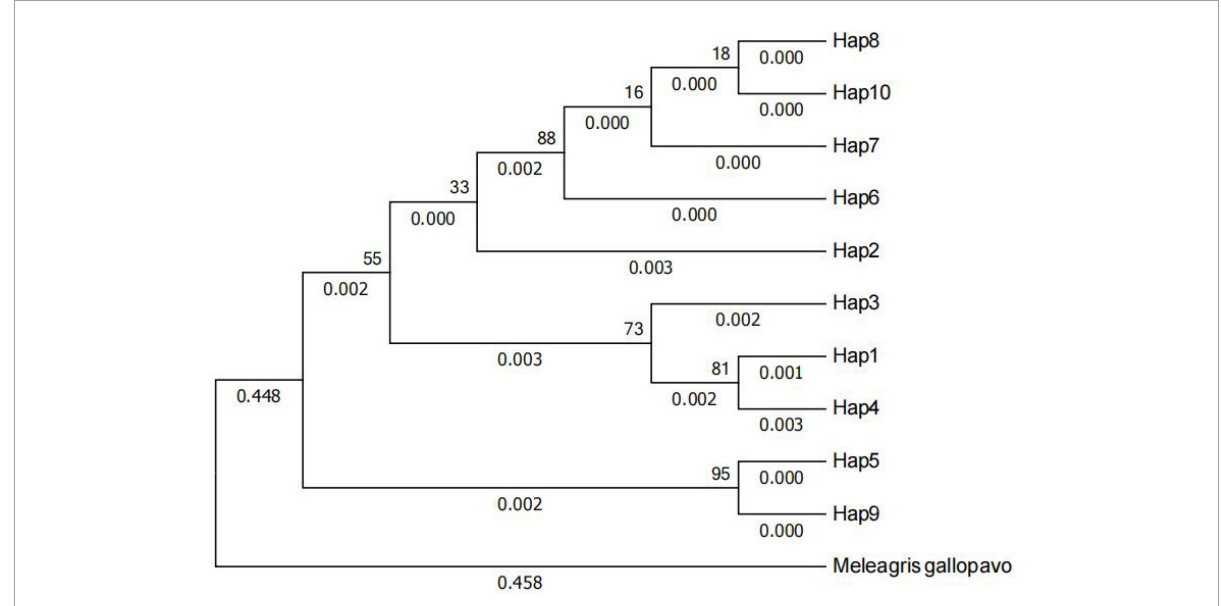
FIGURE4 Phylogenetic tree of the 10 haplotypes of Anjian chicken was constructed using the adjacency method (NJ). A breed of turkey (EF153719.1) was selected as the outgroup. The bootstrap value percentage is displayed above the branch.